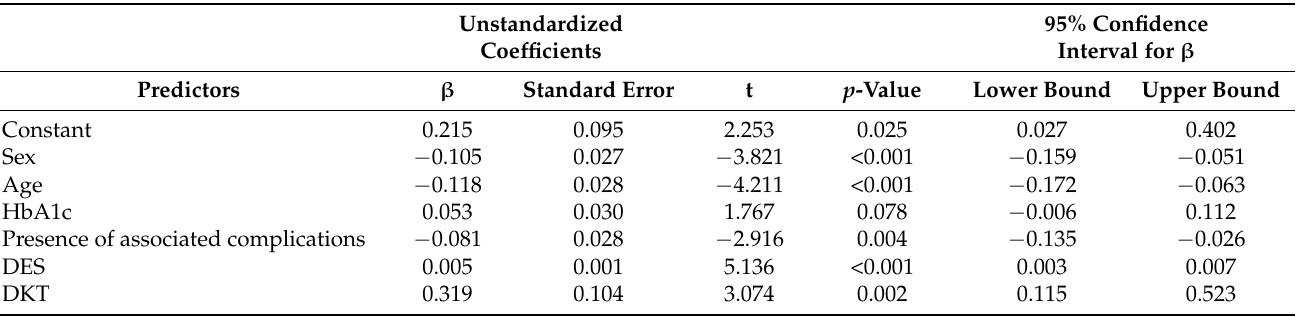
Table 4. Linear regression model results for the EQ-5D-5L.